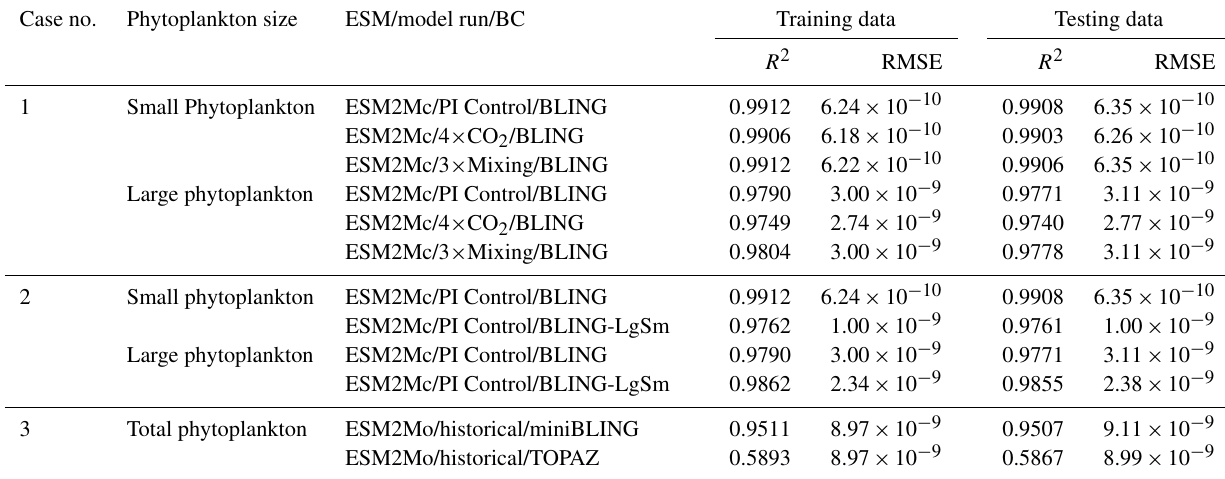
Table 2. The performance metrics for the training and testing subsets for the trained NNEs from each case separated into their respective size classes and ESM and/or model runs. Case